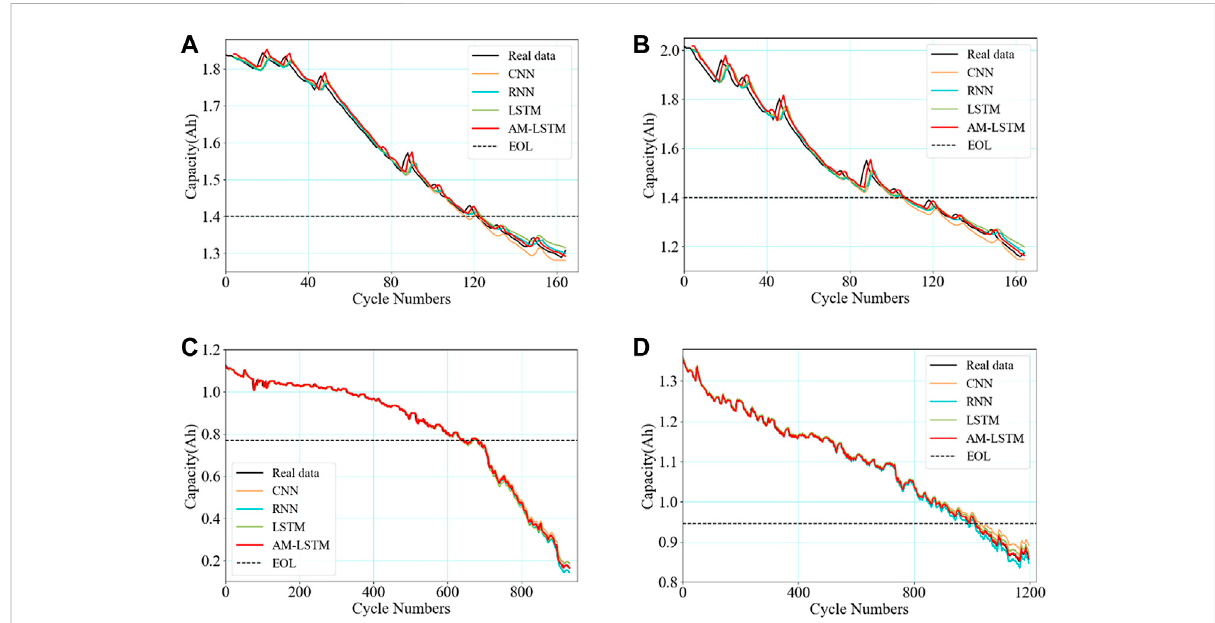
FIGURE 6 Thecapacitypredictionresultsoftheproposedmethodfordifferentbatteriesfromdifferentdatasetscomparedwiththreeotherkindsofneural networks: (A) the capacity prediction result of B5 battery from the NASA dataset; (B) the capacity prediction result of B6 battery from the NASA dataset; (C) the capacity prediction result of CS36 battery from the university of Maryland dataset; (D) the capacity prediction result of CX37 battery from the university of Maryland dataset.